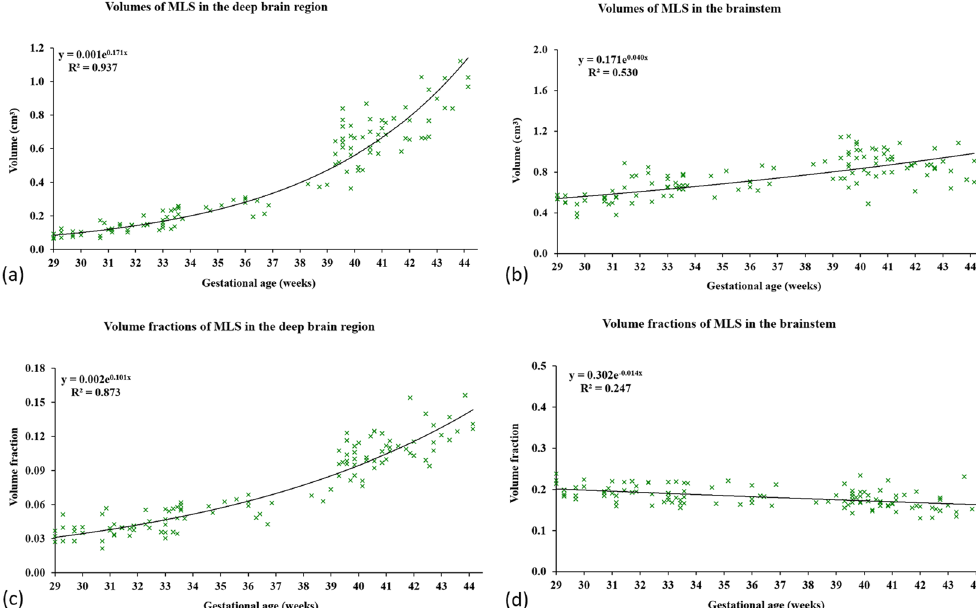
Figure 1. ( a , b ) Volumes of the automatic segmentations for myelin-like signals (MLS) in the deep brain region and brainstem obtained using the proposed segmentation method, ( c , d ) volume fractions of MLS plotted against the gestational ages at scan (GAs) of 114 subjects between 29 and 44 weeks GA. In deep brain region the MLS volume appears to grow exponentially with GA, and this trend persists in the MLS volume fraction after correcting for the different sizes of the deep brain region in individual subjects. In brainstem the trend for MLS volume appears nearly linear with GA, which results in an almost constant MLS volume fraction after correcting for the different sizes of the brainstem in individual